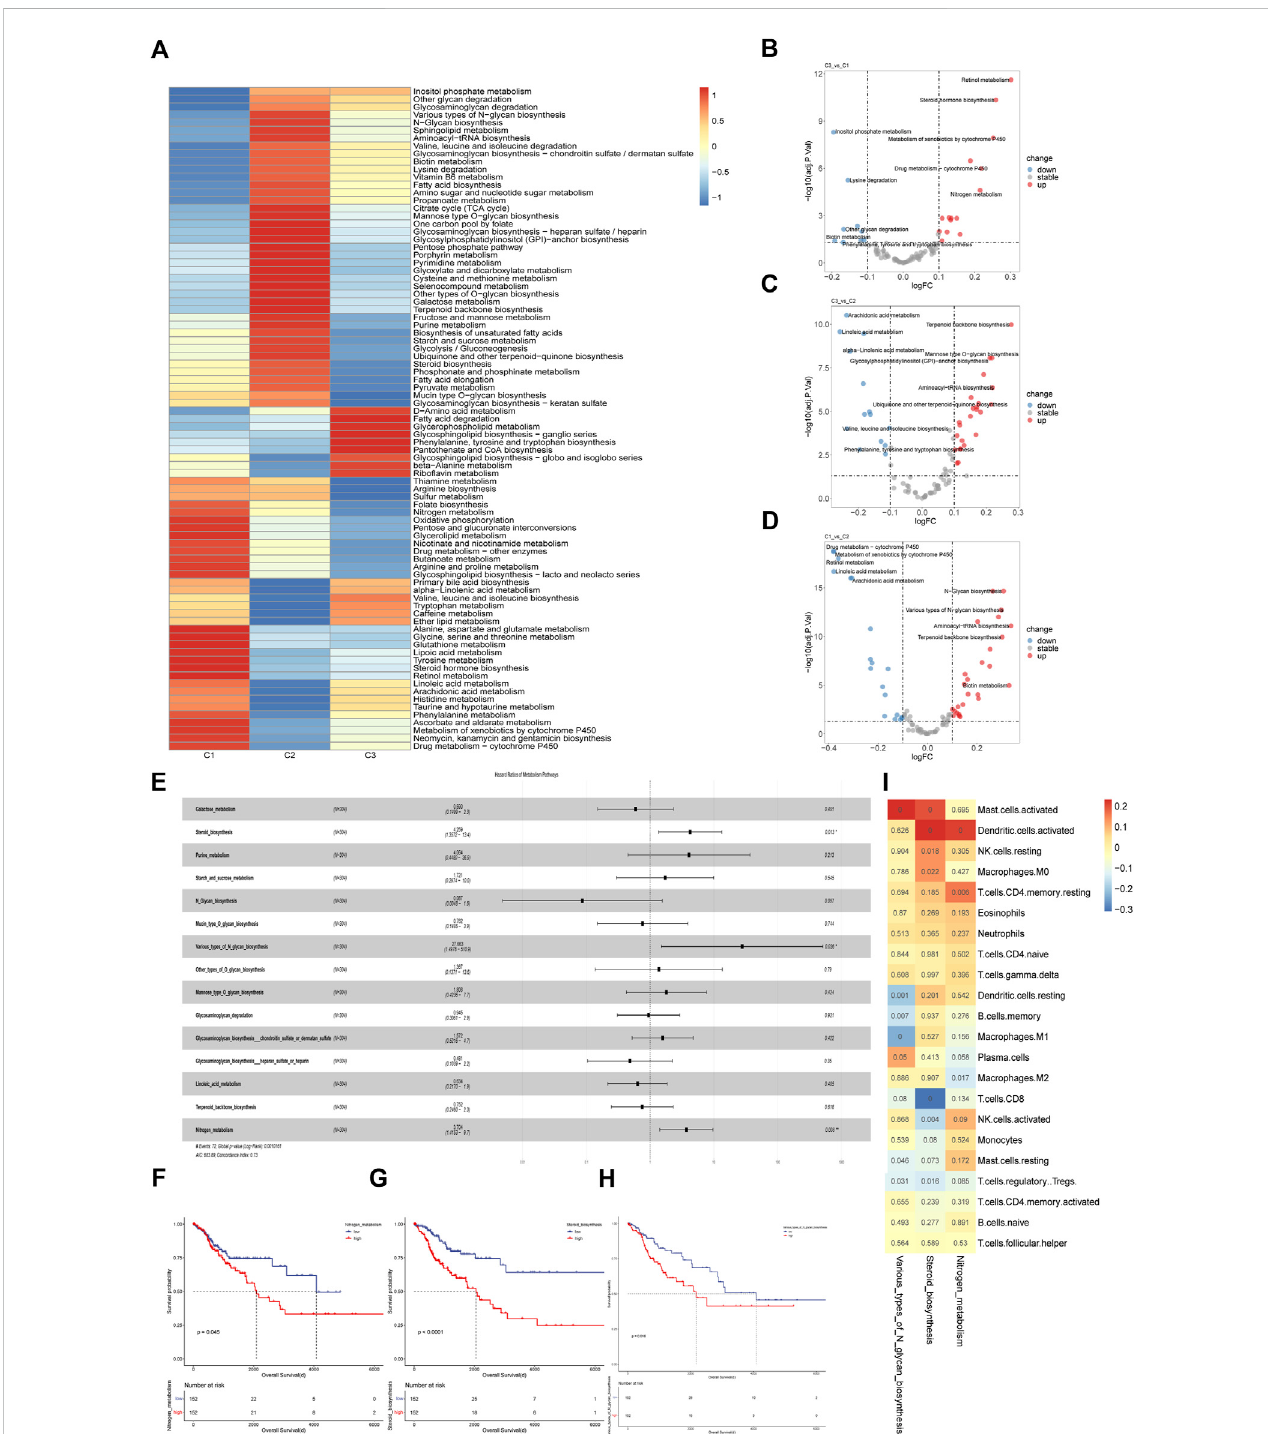
FIGURE 3 Metabolic characteristicsofcervicalcancersubgroups (A) Heatmapofdifferentiallyenriched metabolic pathwaysinthree subtypesinTCGAcohort.The enrichment analysis was performed with GSVA algorithm. (B – D) Volcano plot of differentially enriched metabolic pathways among three subtypes in TCGA cohort. The differential analysis was performed based on the GSVA analysis. (E) Multivariate cox regression model constructed based on the metabolic pathways with prognostic value in univariate cox analysis. (F – H) Kaplan-Meier curves of overall survival between cohorts in TCGA with high and low enrichmentscoreofnitrogenmetabolism,steroidbiosynthesisandvarioustypesofNglycanbiosynthesis.TheenrichmentanalysiswasperformedwithGSVA algorithm. (I) Correlation matrix of the speci fi c metabolic pathways and the 22 immune cells in fi ltrated in the whole cohort. Correlation coef fi cients are represented in the form of heatmap using colored scale ranging from blue (minimum correlation) to red (maximum correlation) and the p -value were